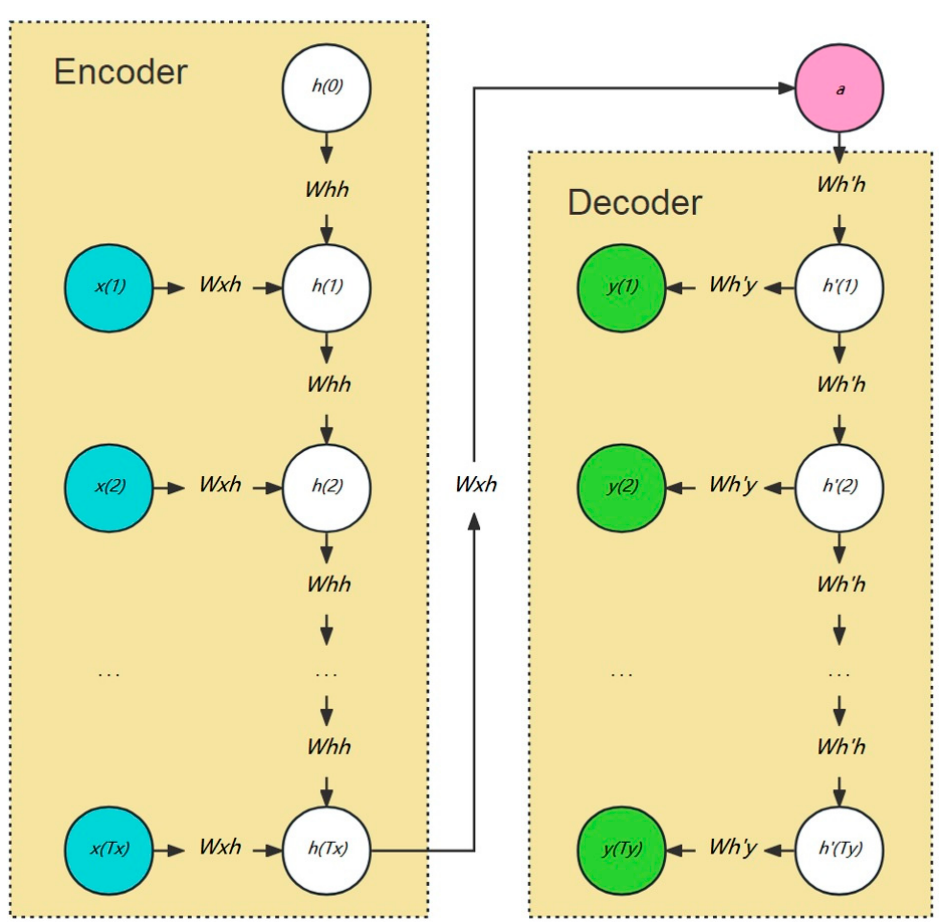
Figure 2. Encoder–decoder architecture .